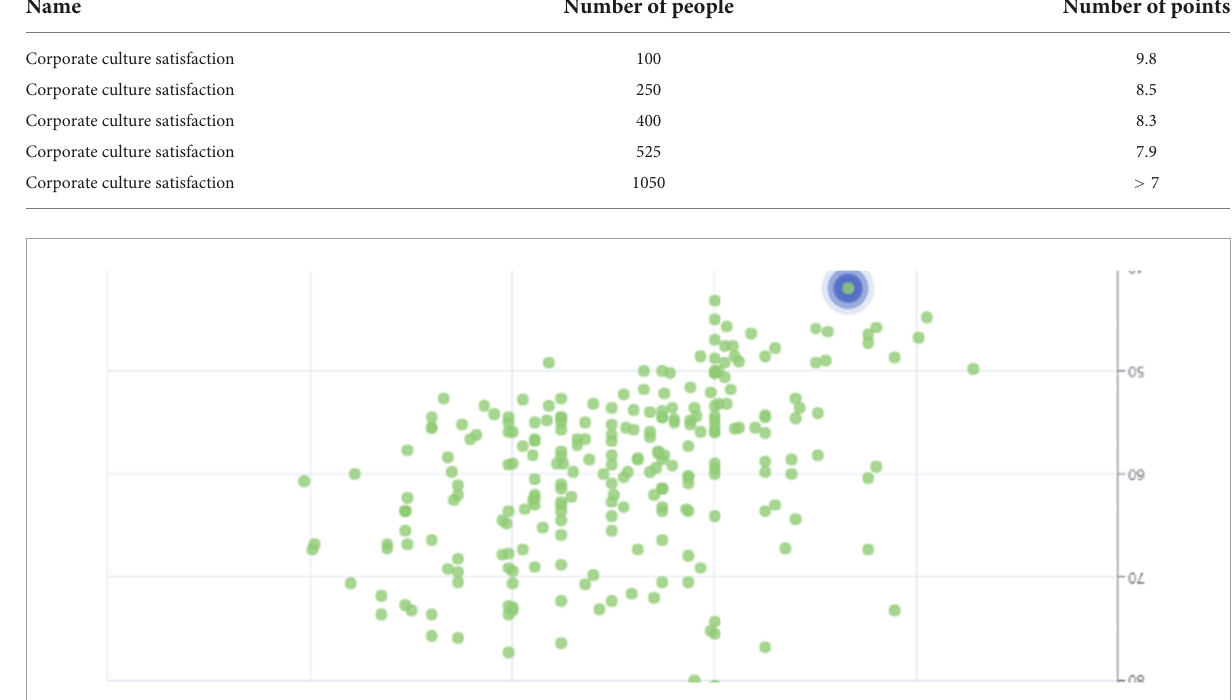
FIGURE3 Distribution of sentiment